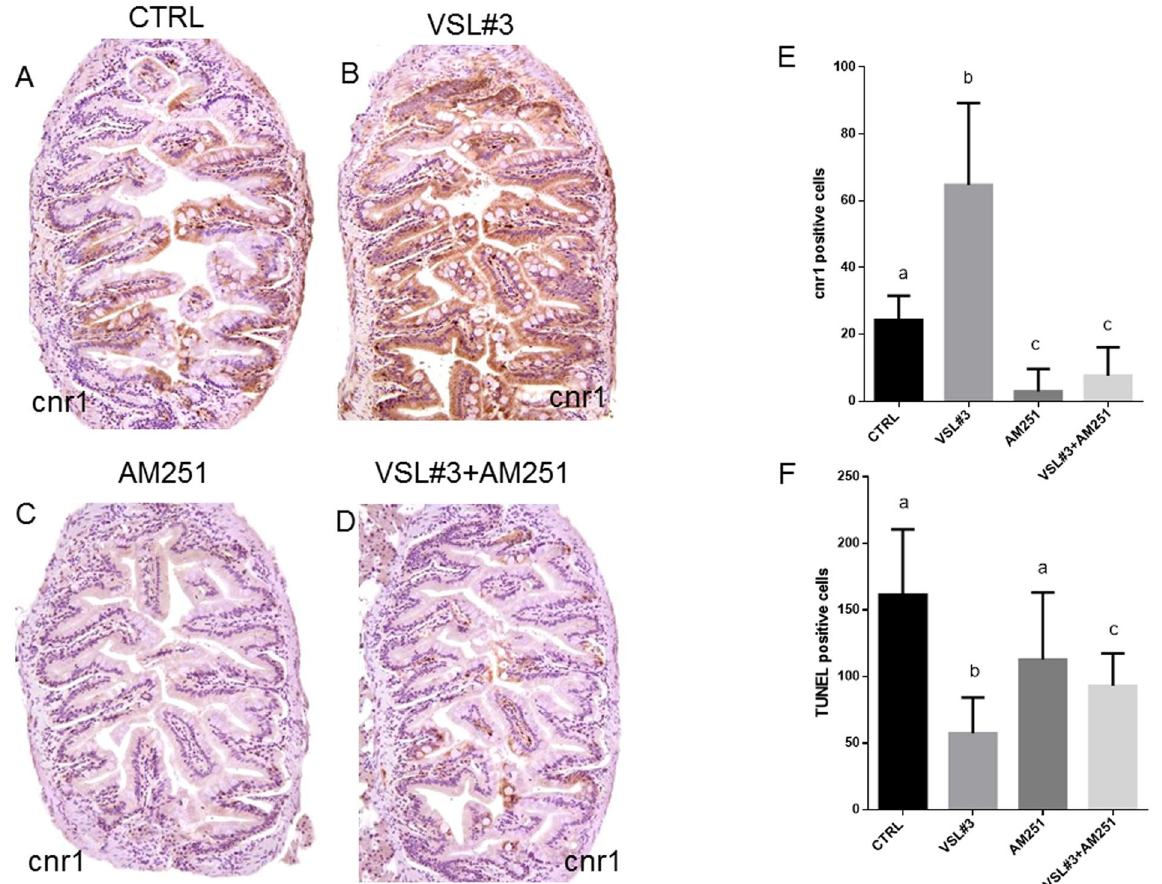
Figure 6. Intestinal distribution of cnr1 by IHC in different experimental groups from ex vivo experimentation: ( A ) Control; ( B ) VSL#3; ( C ) AM251; ( D ) VSL#3 + AM251. ( E ) Cnr1 protein levels by IHC and ( F ) TUNEL positive cell count in the same ex vivo experimental groups. Values indicate mean ± SD. Different letters denote significant differences among